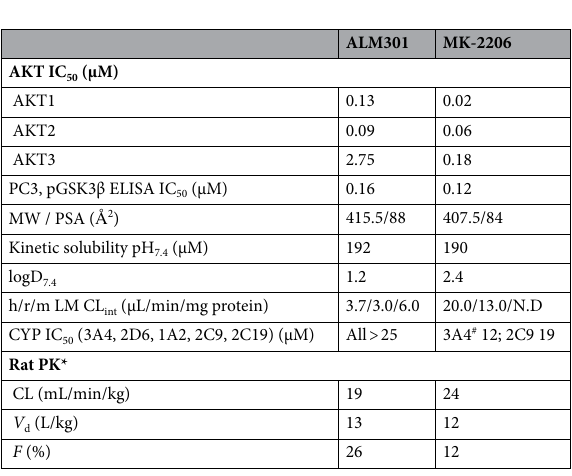
Table 2. Potency, physicochemical and early ADME profiling of ALM301 and MK-2206. LM: Liver microsomes. *Male SD rats at 1 mg/kg i.v. and 5 mg/kg p.o. PK parameters calculated based on AUC 0-∞. # > 2.7 fold Time Dependent Inhibition (TDI) of CYP3A4